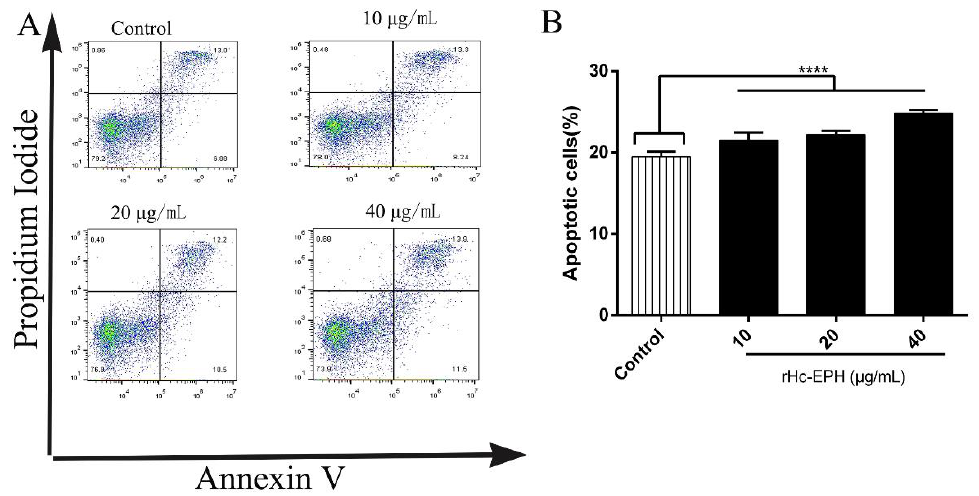
Figure 6. Measurement of rHcEPH on PBMCs apoptosis by flow cytometry. PBMCs were treated with serial concentrations of rHcEPH and PBS. ( A ): Dot plots showing apoptosis (early and late stage) of PBMCs in response to exposure to rHcEPH protein, ( B ): Percentage of apoptosis (early and late stage) of PBMCs after rHcEPH treatment. The data is denoted as mean ± SEM of three independent experiments (**** p < 0.0001).